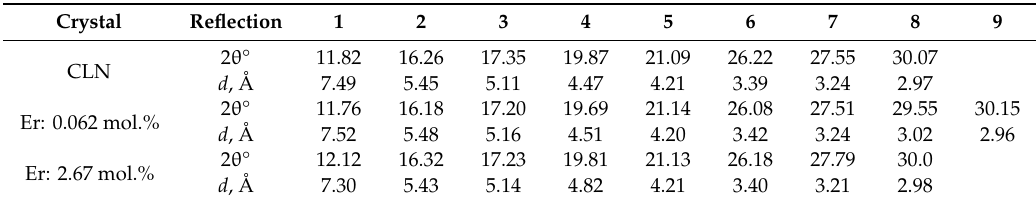
Table 5. A list of phases from the ICSD